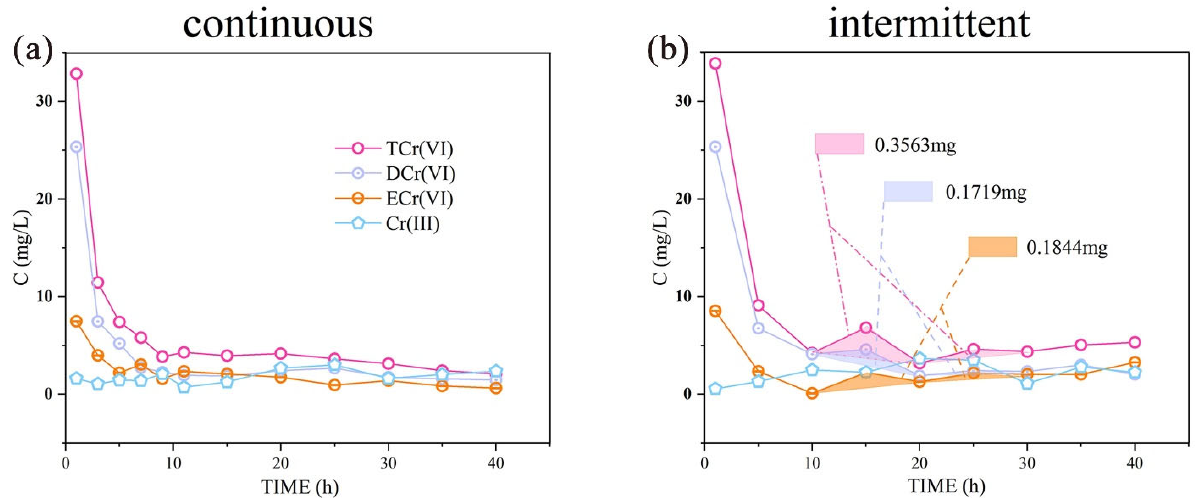
Figure 5. Influence of different precipitation modes on Cr transfer and transformation. ( a ) Continuous represents a continuous leaching experiment of 40 h. ( b ) Intermittent represents a pulsed leaching experiment, in which leaching was alternately conducted for 5 h, followed by a pause of 5 h and the total duration was 40 h. The shaded area indicates the amount of Cr leached during the experiment duration of 10–20 h.